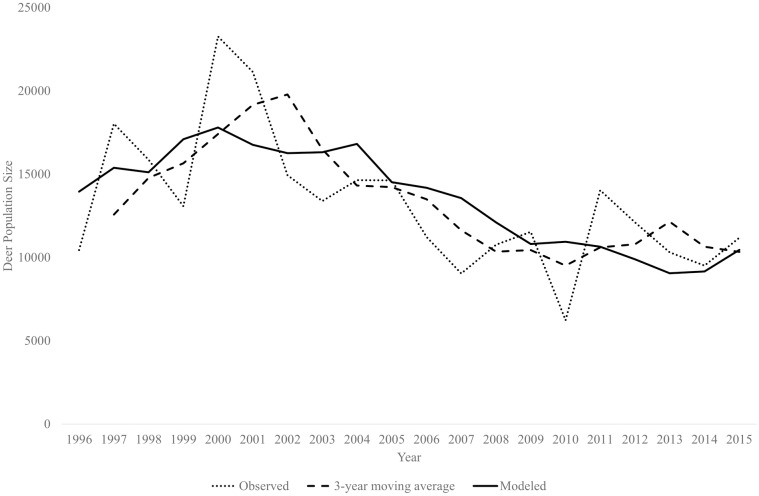
Comparison between observed, 3-year moving average, and modeled deer population size trends.White-tailed deer were counted via helicopter surveys in South Texas during 1996–2015 and compared well with output of parameter validation model (solid line).